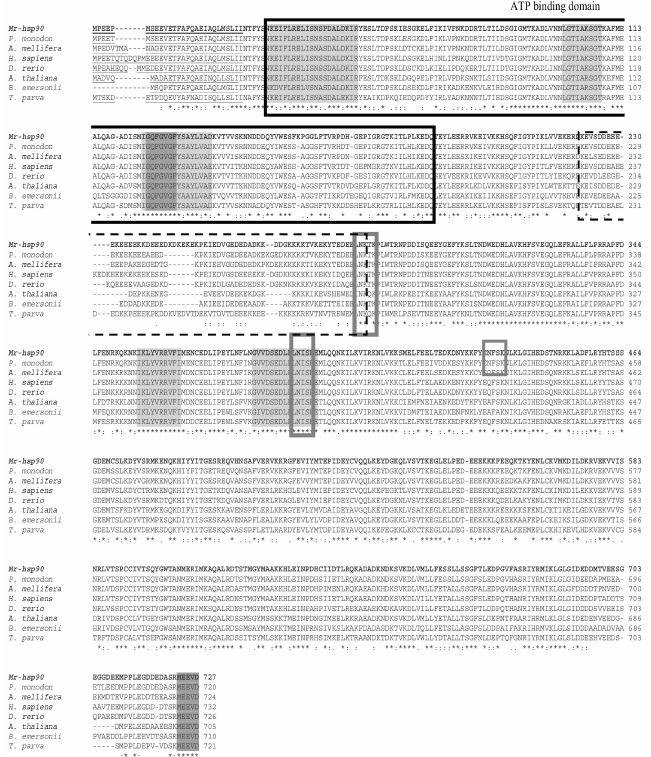
Figure 4. Multiple sequence alignments of Mr-hsp90 with those of other species found in the GenBank database. HSP90 family signature sequences and the consensus sequence “MEEVD” at the C-terminus are shaded with boxes. The symbols (*, : and .) in the CLUSTAL W alignment represent identical residues, conserved substitutions and semi-conserved substitutions, respectively. The accession numbers of the other species are shown in Figure